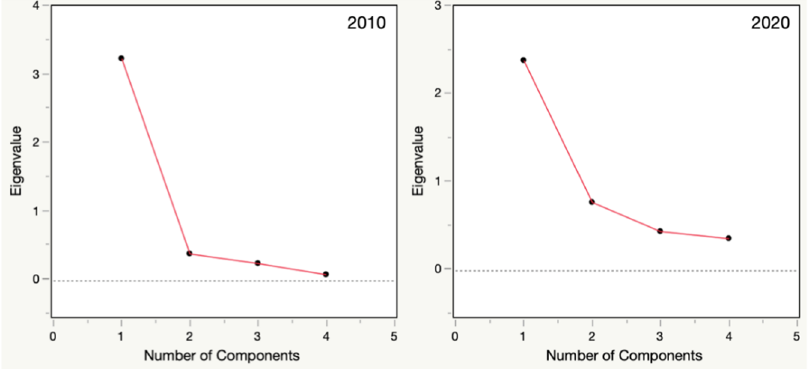
Figure 2. Scree plot of Chinese fisherfolk incomes in 2010 and 2020. Source: Authors’ own calculations based on data from China Fisheries Statistical Yearbook 2011 and China Fisheries Statistical Yearbook 2021.